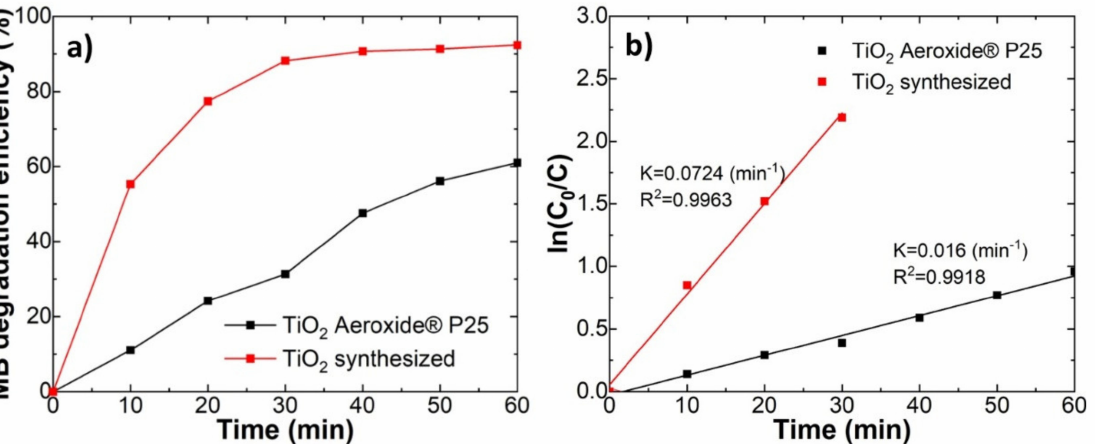
Figure 2. Comparison between the synthesised TiO 2 and commercial Aeroxide ®® P25 TiO 2 powders. ( a ) the degradation efficiency of methylene blue (MB); ( b ) and the linear kinetic